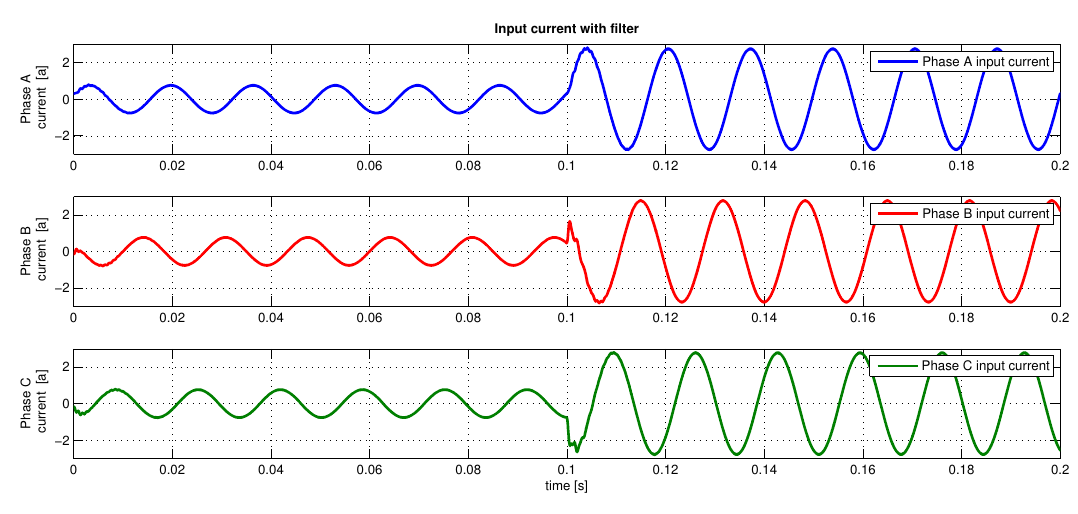
Figure 11. Output voltage with filter.